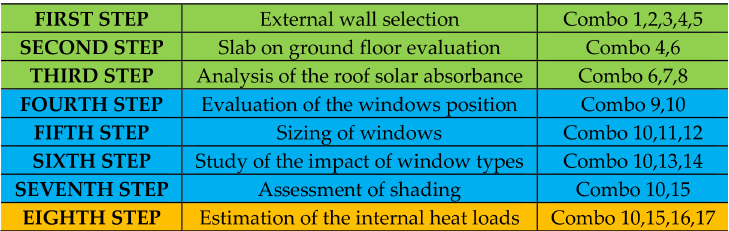
Table 1. Development of the